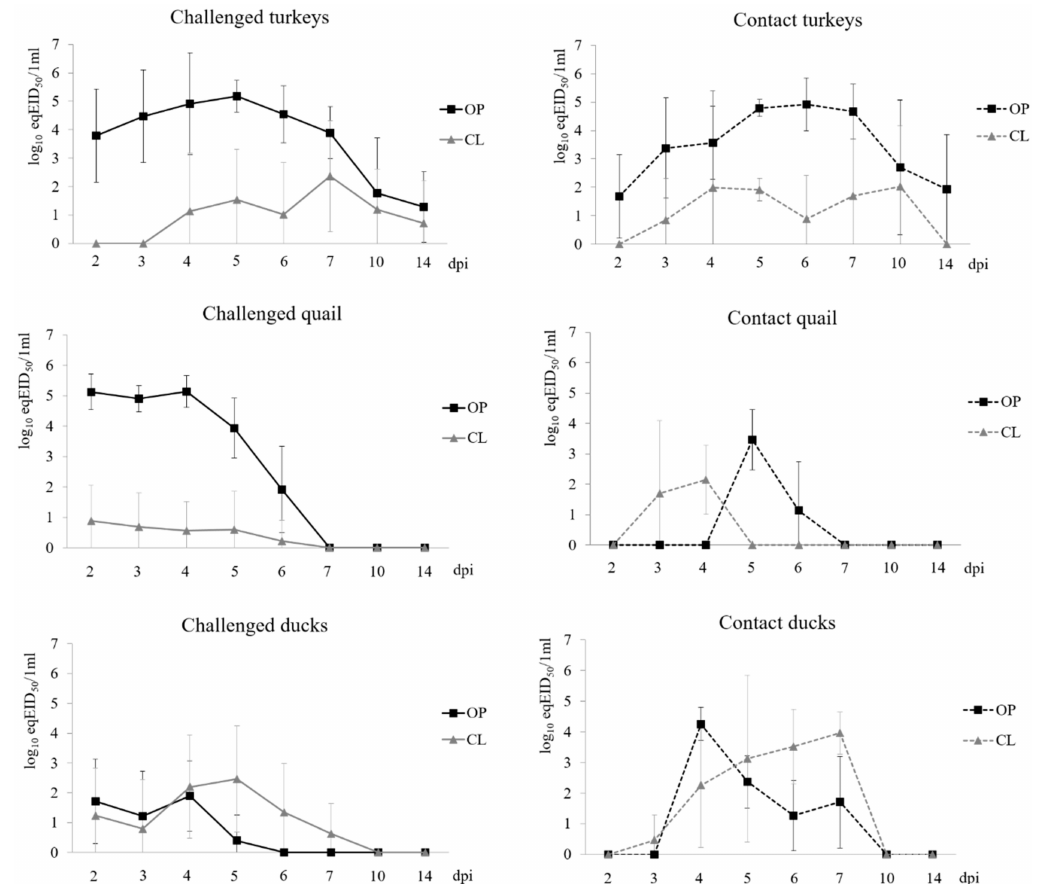
Figure 1. Shedding of H9N2 AIV in challenged (inoculated) and contact (secondarily exposed) turkeys, quail and ducks. OP – oropharyngeal swabs, CL – cloacal